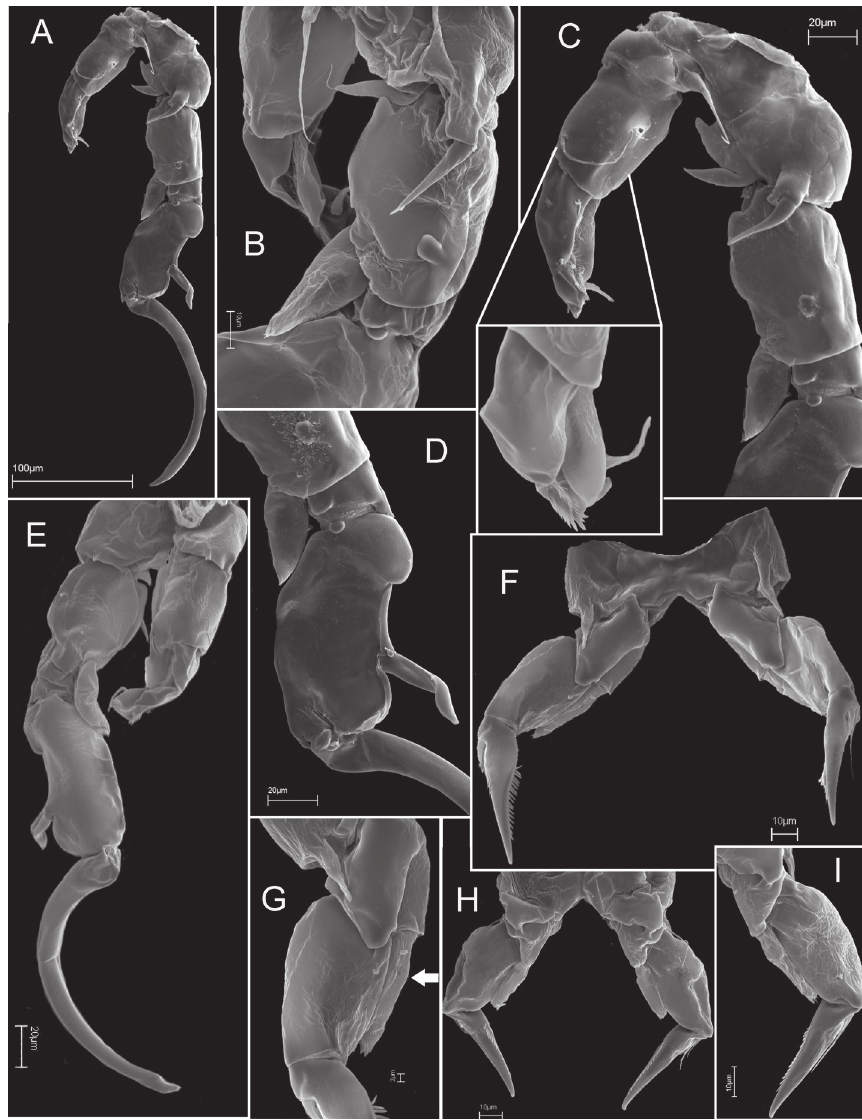
Figure 5. Mongolodiaptomus loeiensis sp. n., SEM photographs. Male ( A–E ): A P5 in caudal view B coxa, basis, Exp-1 of the right P5 in caudal view C intercoxal plate, coxa, basis, Enp of the right P5 and coxa, basis, Exp and Enp of the left P5, caudal view D Enp and Exp of the right P5 in caudal view E P5 in frontal view; Female ( F–I ): F P5 in caudal view G basis, Exp-1 and Enp in caudal view (white arrow indicated the segmented point of Enp) H P5 in frontal view I the left P5 in frontal view. with a cluster of strong spinules along inner margin; apical process stout, bare, and short. Enp 1-segmented, longer than Exp-1, with a cluster of spinules at its tip. Etymology. The specific name loeiensis refers to the place “Loei” where the new spe- cies was first recognized. The name with the Latin suffix “- ensis ” is an adjective for